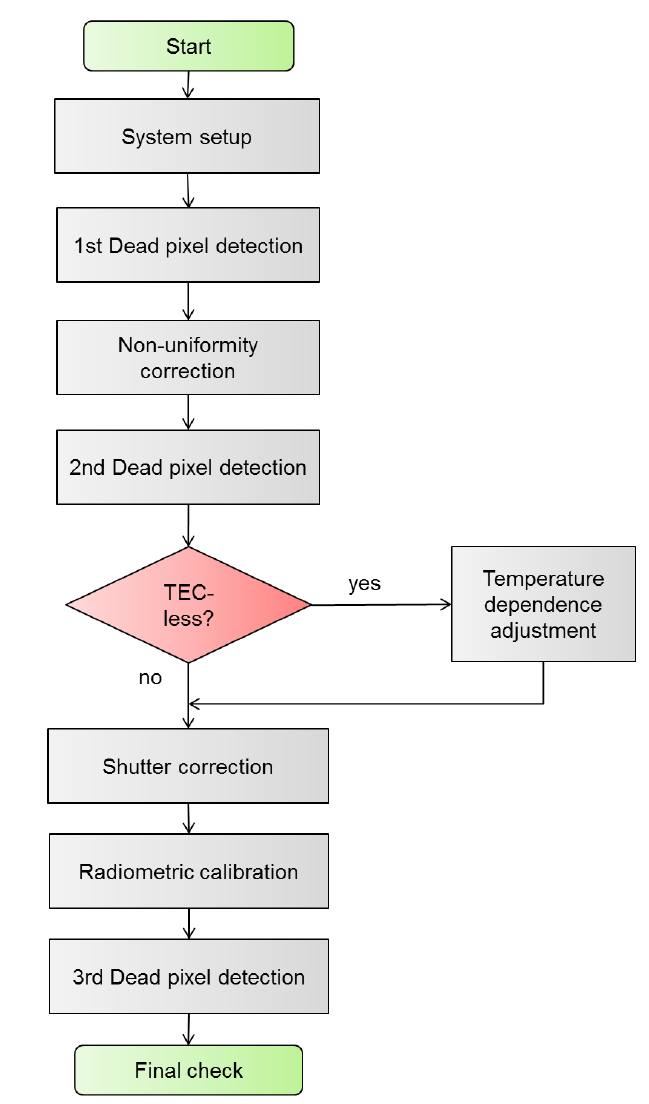
Figure 5. Flow chart of radiometric calibration.